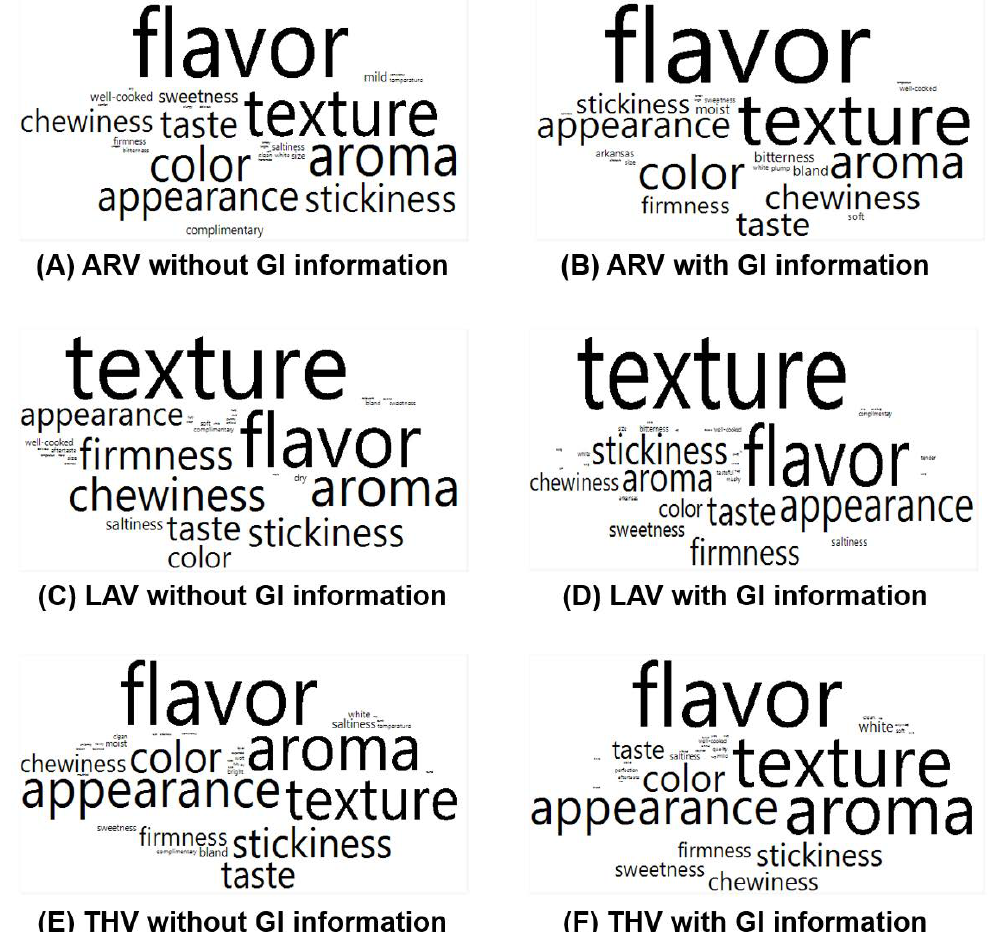
Figure 4. Geographical indication (GI) information-induced variations in the relative percentages of positive terms for each of the three cooked aromatic rice samples: ( A and B ) ARoma 17 (ARV), ( C and D ) Jazzman-2 (LAV), and ( E and F ) Jasmine from Thailand (THV). The size of a term in the visualization represents the number of responses reported as what participants liked for each of the three cooked aromatic rice samples. The layout of each term has no specific meaning. A list of terms reported by at least 10 participants for each cooked aromatic rice sample is shown in Table S4.